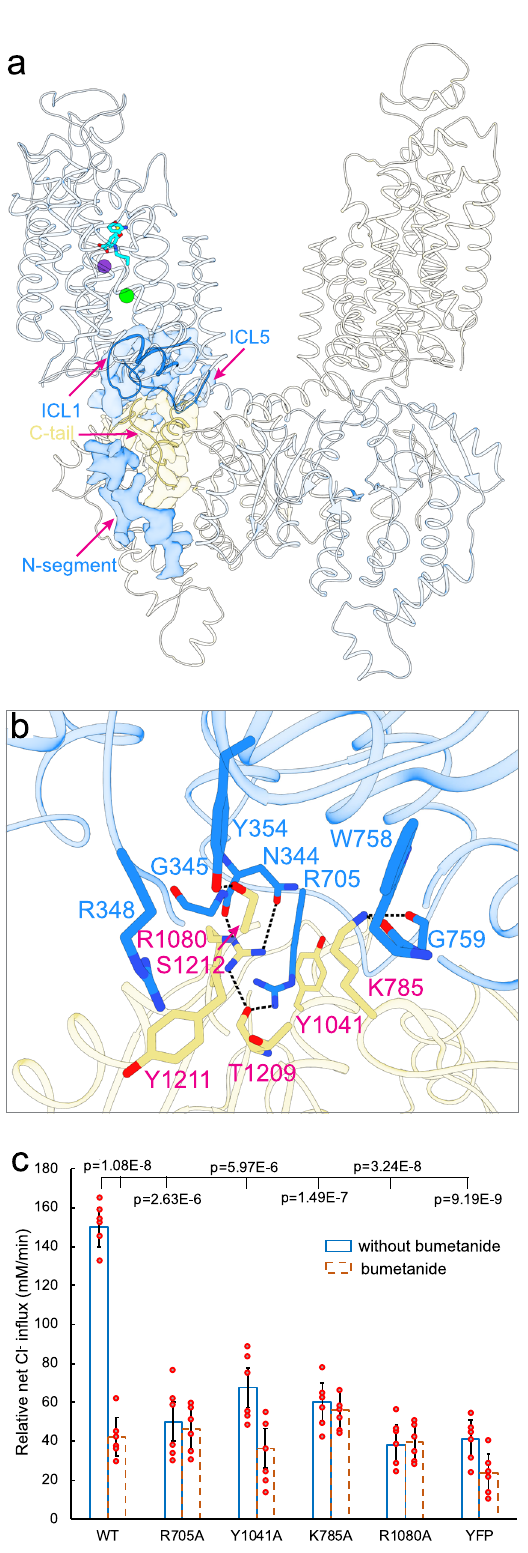
two transmembrane units is apparently not triggered by the outward- open conformation for two reasons: (1) the outward-open NKCC1 ii / bumetanide structure also assumes a transmembrane associated arrangement; and (2) the TM11-turn-TM12 structure that mediates dimerization within the membrane assumes a similar orientation with respect to the TM1-TM10 helices regardless of whether NKCC1 adopts an inward- or outward-open state. We compared the